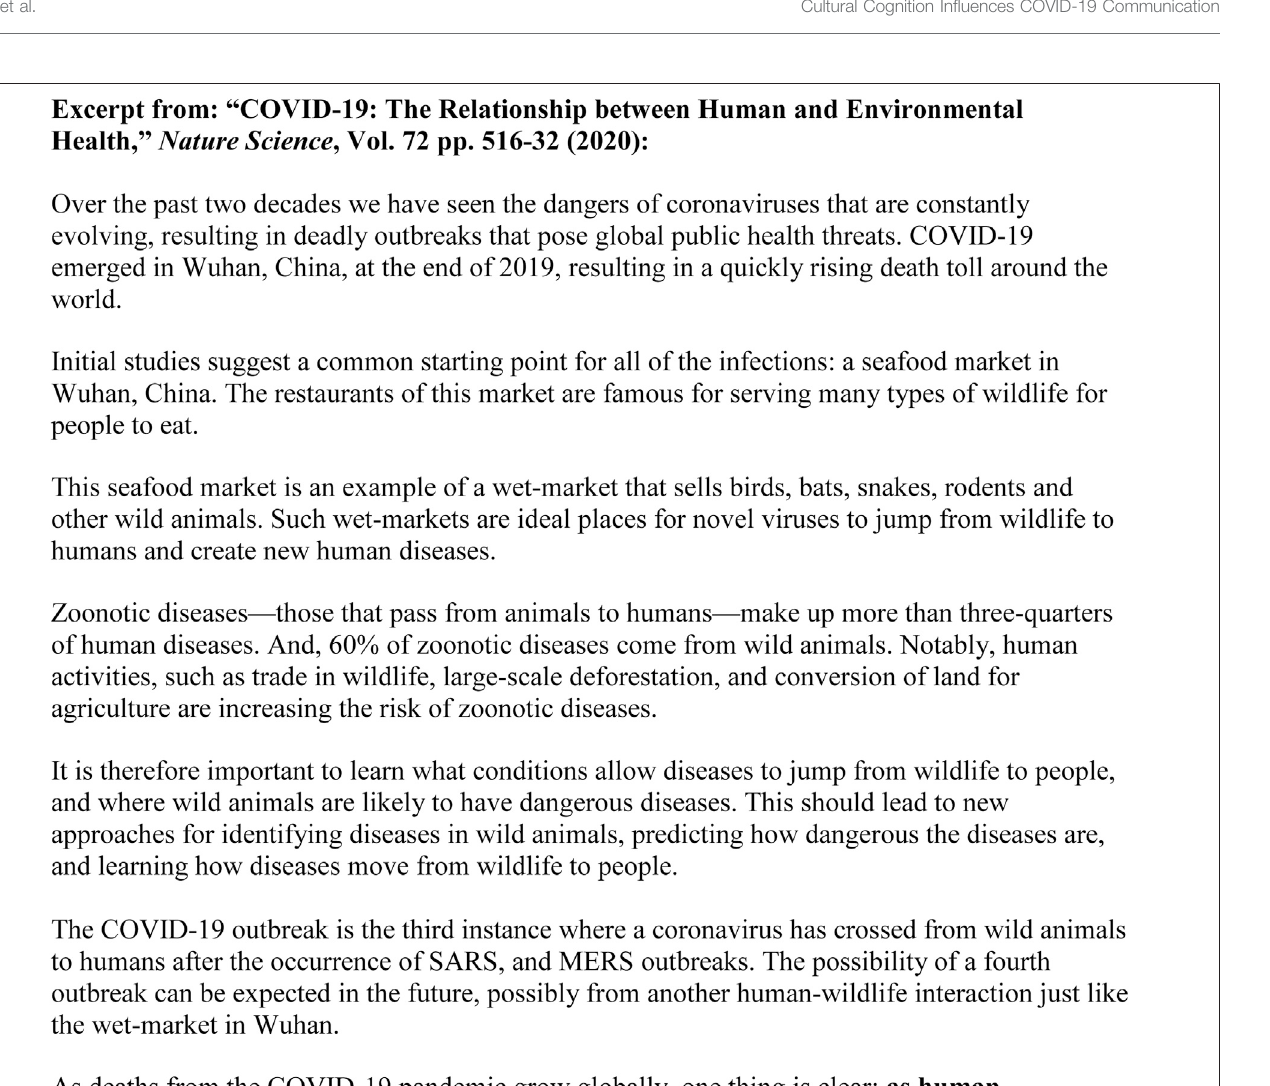
Frontiers in Communication |